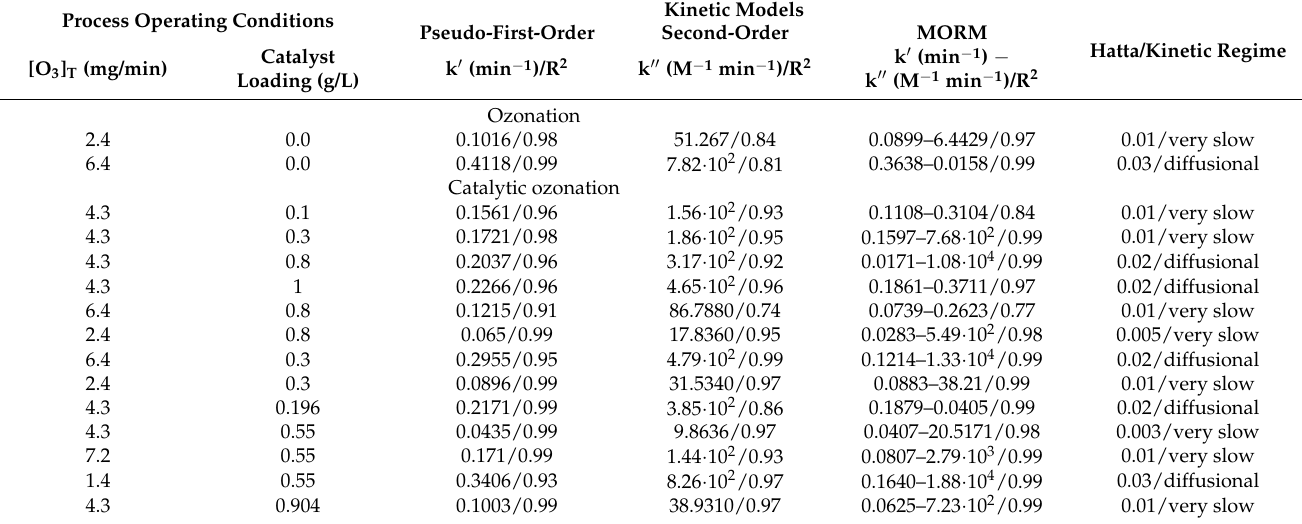
Table 3. Reaction rate constants/R 2 for different reaction models, Hatta and kinetic regime as a function of the process and operating